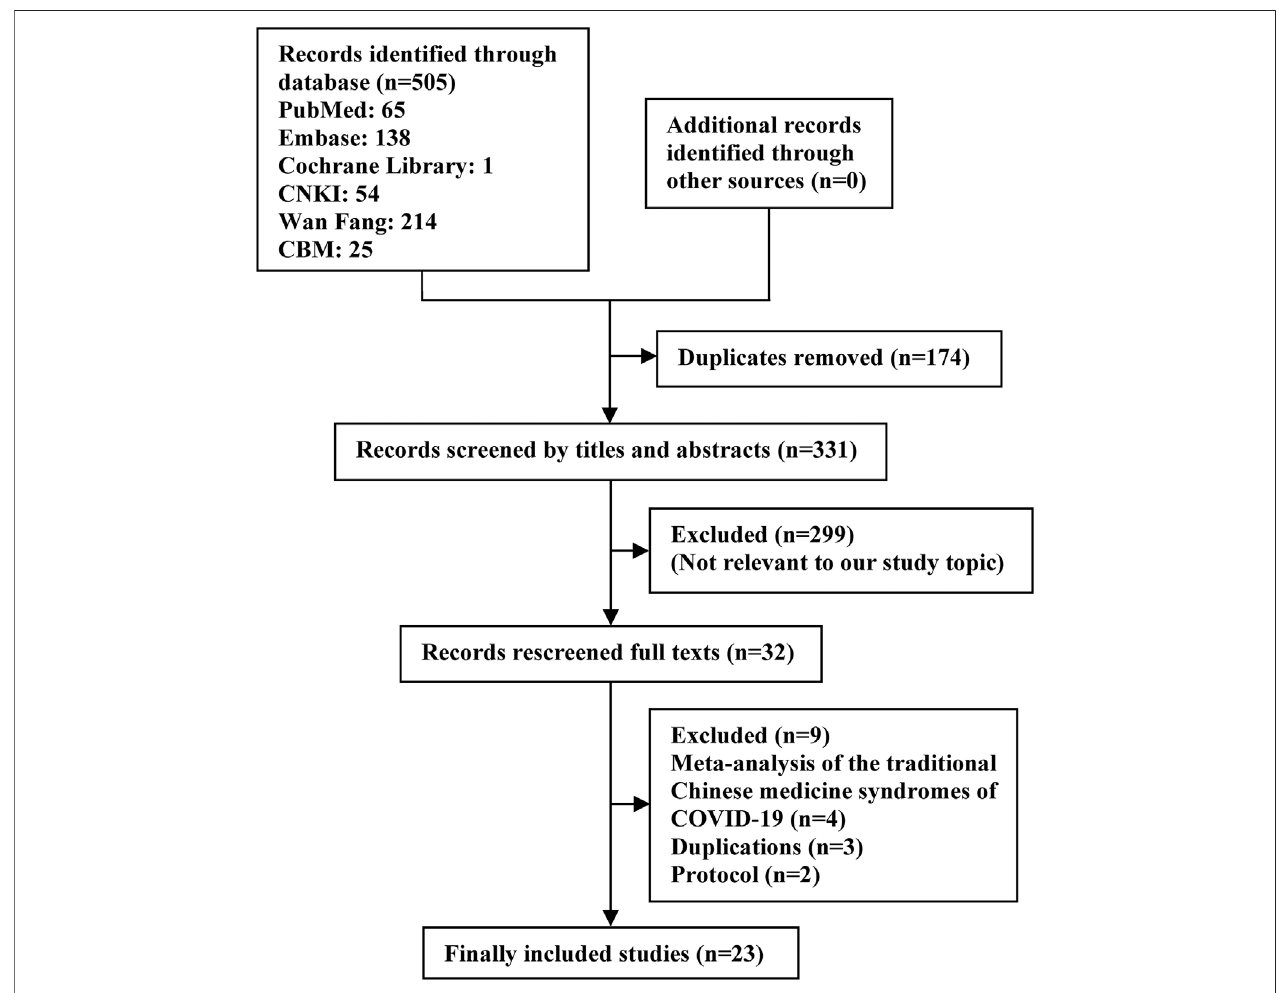
FIGURE 1 | Flow diagram showing the search process and study